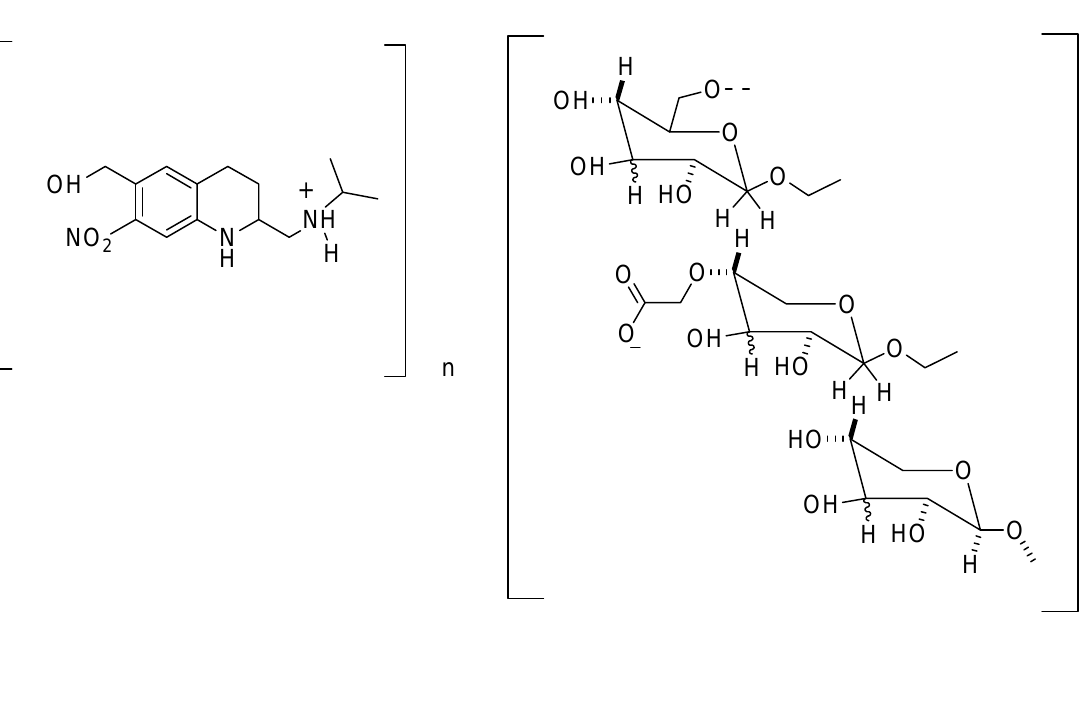
Figure 32: Chemical structure of the dextran-methylcarboxylate prodrug of oxamniquine.